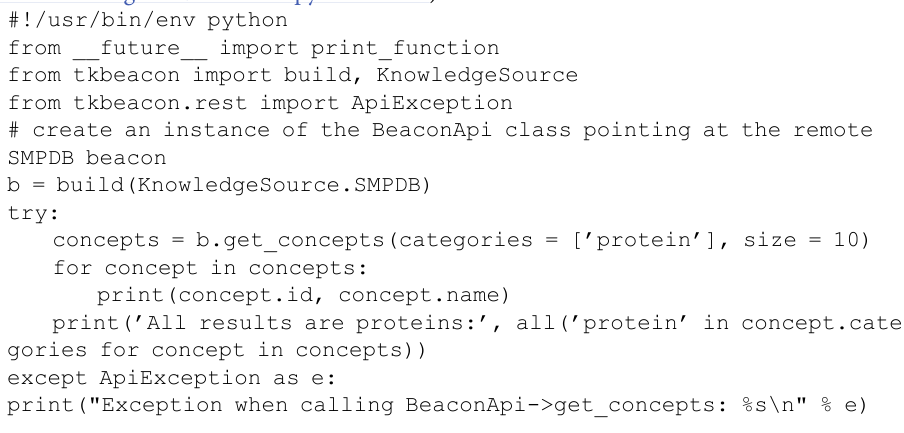
Table 1. The Java and Python software implementations of these Beacons are available in repositories of the NCATS-Tangerine (https://github.com/NCATS-Tangerine) GitHub orga- nization. One implementation is a generic accessor of Biolink Model compliant knowledge graph databases stored in Neo4j (https://github.com/NCATS-Tangerine/tkg-beacon). These Beacon implementations may be tested using an available validator application (https://github. com/NCATS-Tangerine/beacon-validator). A Python command line Beacon client is available (https://github.com/NCATS-Tangerine/tkbeacon-python-client). A Knowledge Beacon Aggregator (https://github.com/NCATS-Tangerine/beacon-aggregator-client) was also